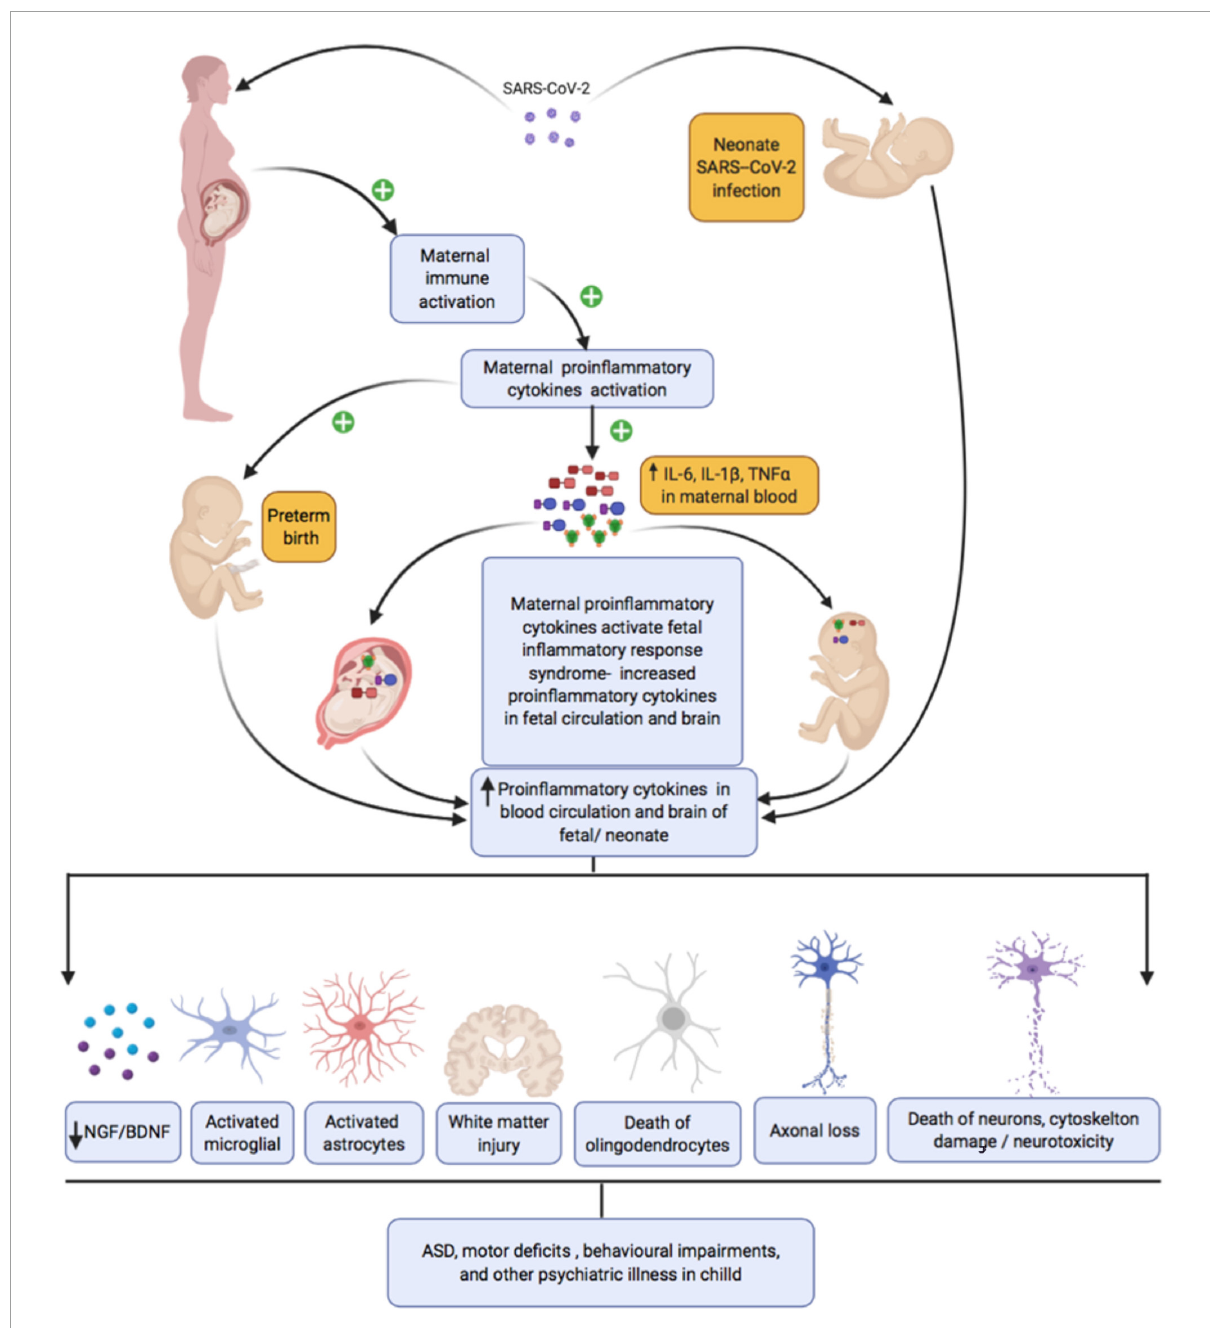
FIGURE3 Maternal SARS-CoV-2 infection, inflammation, and subsequent fetal/neonatal brain